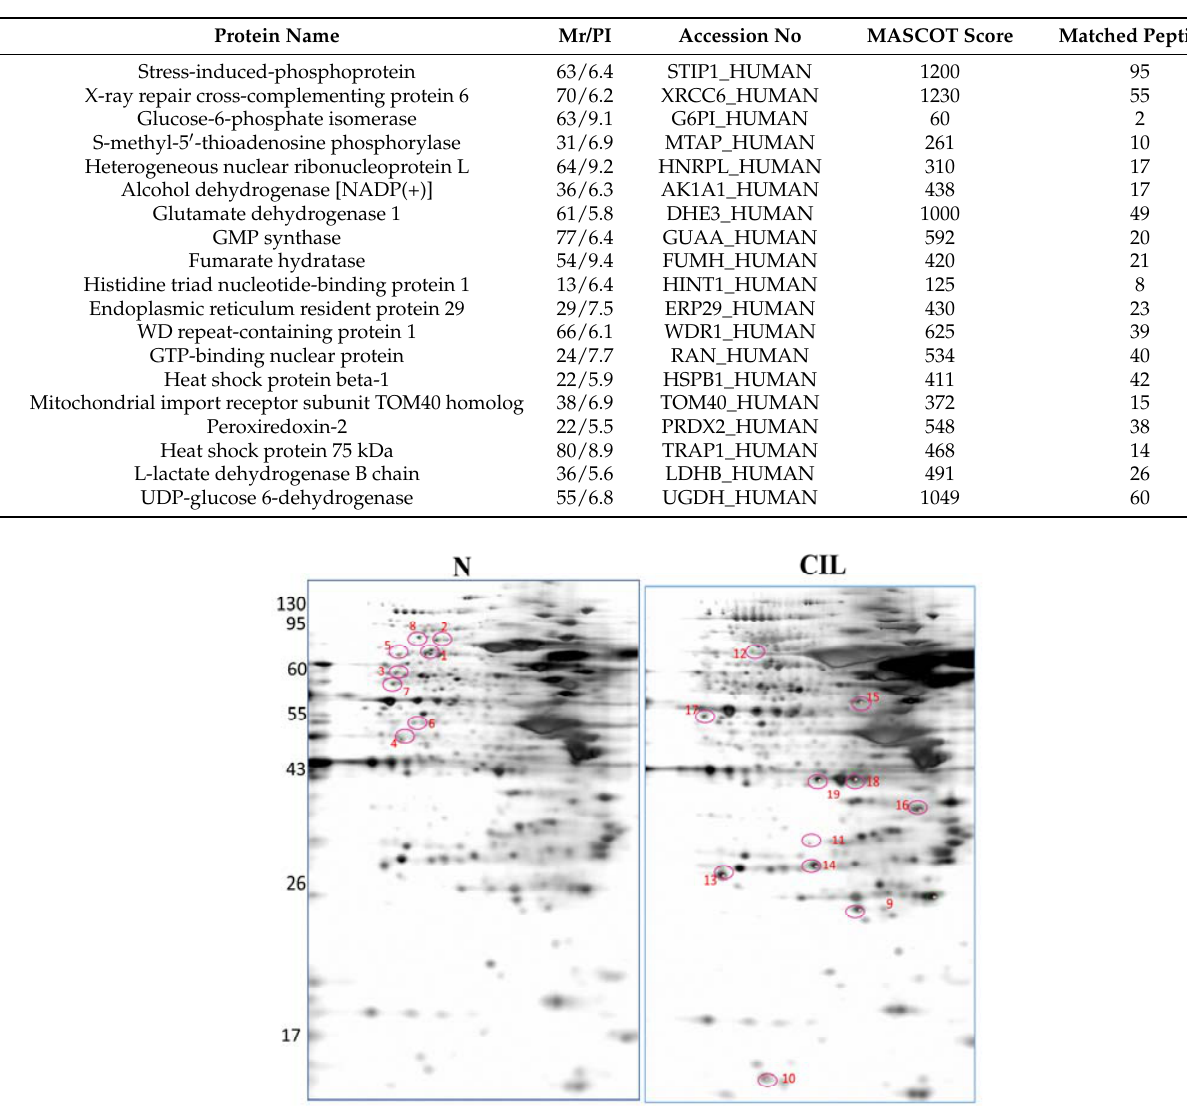
Table 1. Differentially expressed protein.